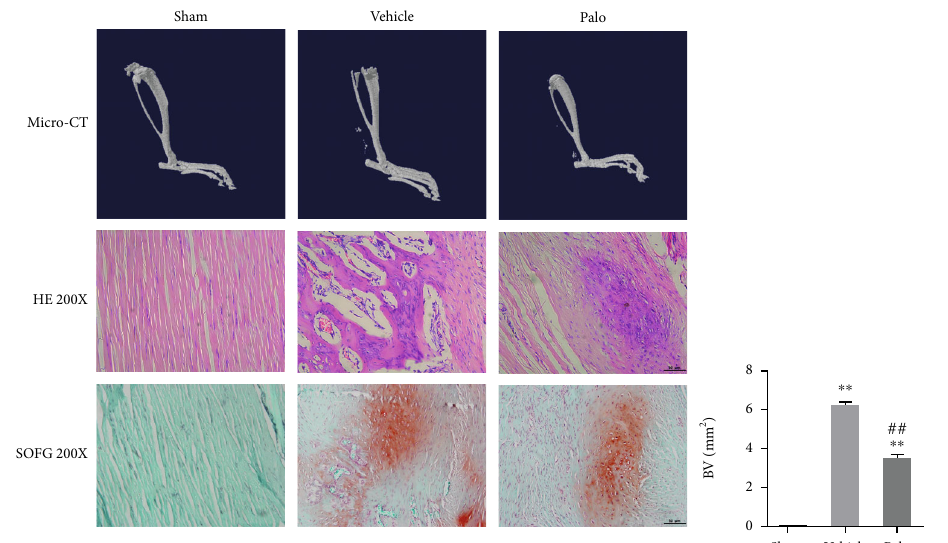
Figure 5: Micro-CT, HE, and SOFG staining revealed that palovarotene can attenuate HO. Data are means ± SD ( n = 8 ). ∗ p < 0 : 05 and ∗∗ p < 0 : 01 . # p < 0 : 05 and ## p < 0 : 01 . Scale bar = 50 μ